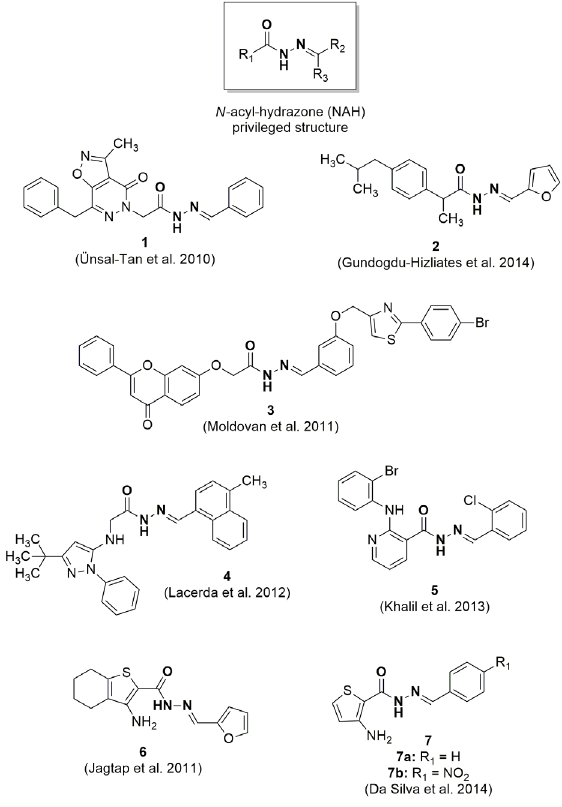
Figure 1 - Analgesic and anti-inflammatory drug candidates presenting the privileged N -acyl-hydrazone (NAH)